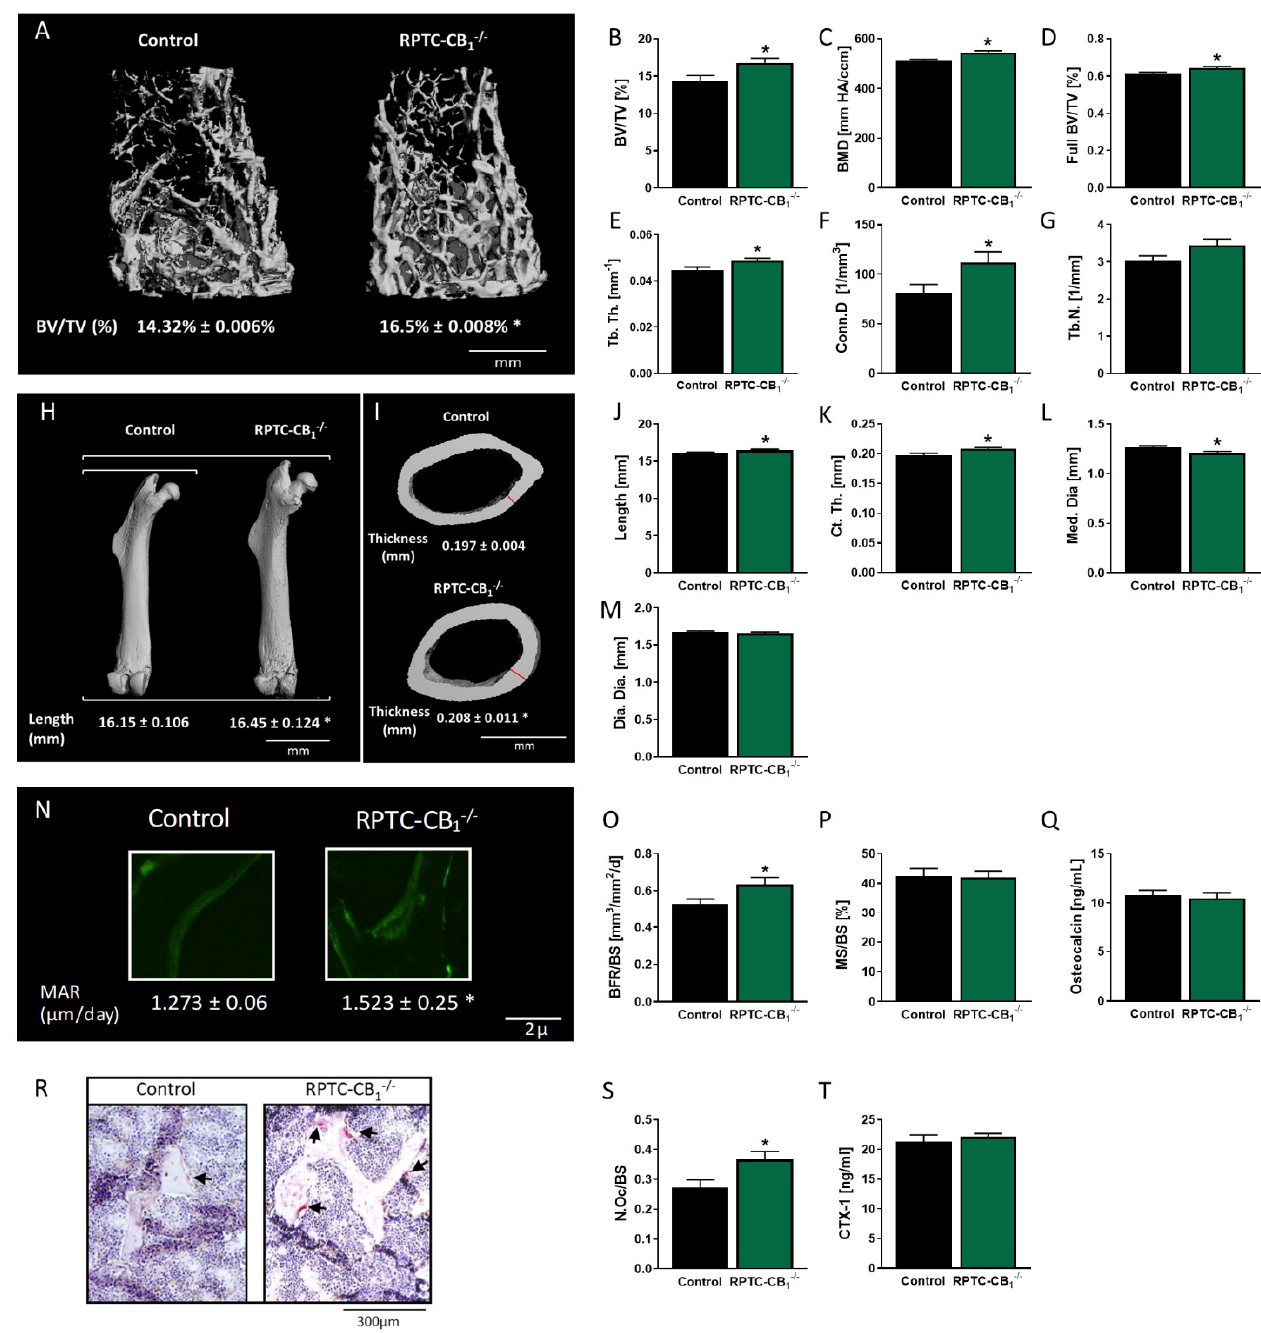
Figure 1. Main endocannabinoid receptor (CB 1 R) in renal proximal tubule cells (RPTCs) modulates bone mass and function under normoglycemic conditions. 3D images of the distal femoral metaphysis of RPTC-CB 1 − / − mice and their littermate wild-type (WT) controls with median bone volume density (BV/TV) values ( A , B ), bone mineral density (BMD; C ), full bone BV/TV ( D ), trabecular thickness (Tb.Th; E ), connectivity density (Conn.D; F ), and trabecular number (Tb.N; G ). 3D images of the femora of RPTC-CB 1 − / − mice and their littermate WT controls with median values of length for each group (Length; H,J ). 3D images of the femoral mid-diaphysis of mice with median values of cortical thickness (Ct.Th) for each group ( I,K ), medullary diameter (Med.Dia; L ), and diaphyseal diameter (Dia.Dia; M ). Histomorphometric analysis of the bone formation parameters. Representative images of calcein-labeled mineralized fronts with mineral apposition rate (MAR) values ( N ), the bone formation rate (BFR/BS; O ), mineralizing surface (MS/BS; P ), and serum osteocalcin levels ( Q ). Images of TRAP+ osteoclasts ( R ), the number of osteoclasts per trabecular surface area (N.Oc/BS; S ), and the serum levels of CTX-1 ( T ). Data represent the mean ± SEM from 10–14 animals per group, * p < 0.05 relative to the corresponding control group.